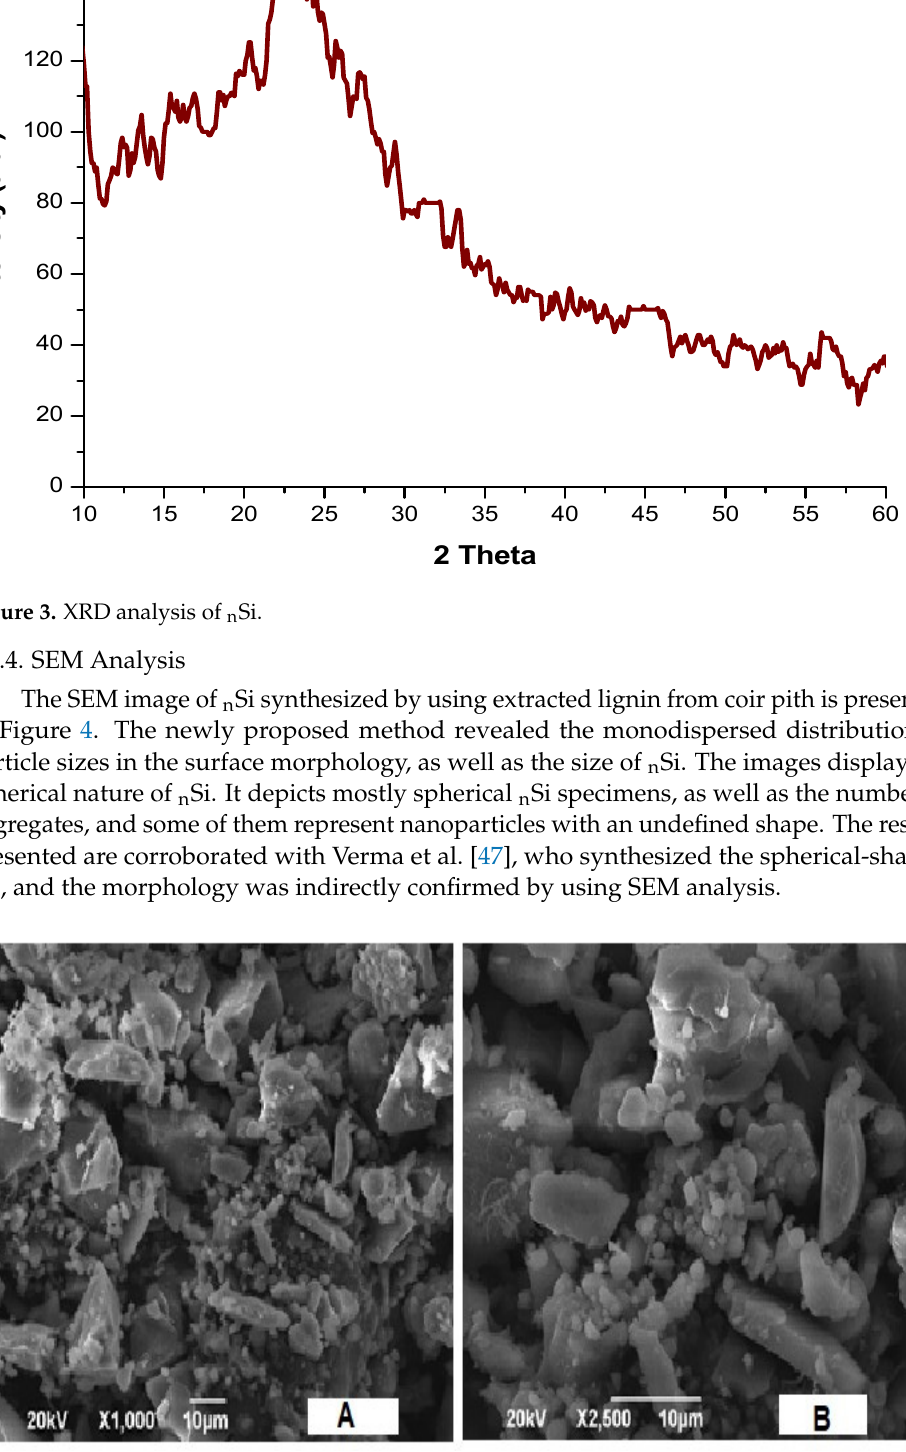
Figure 4. SEM images of n Si. (Spherical-shaped n Si was observed.) (A = X1000 and B = X2500).